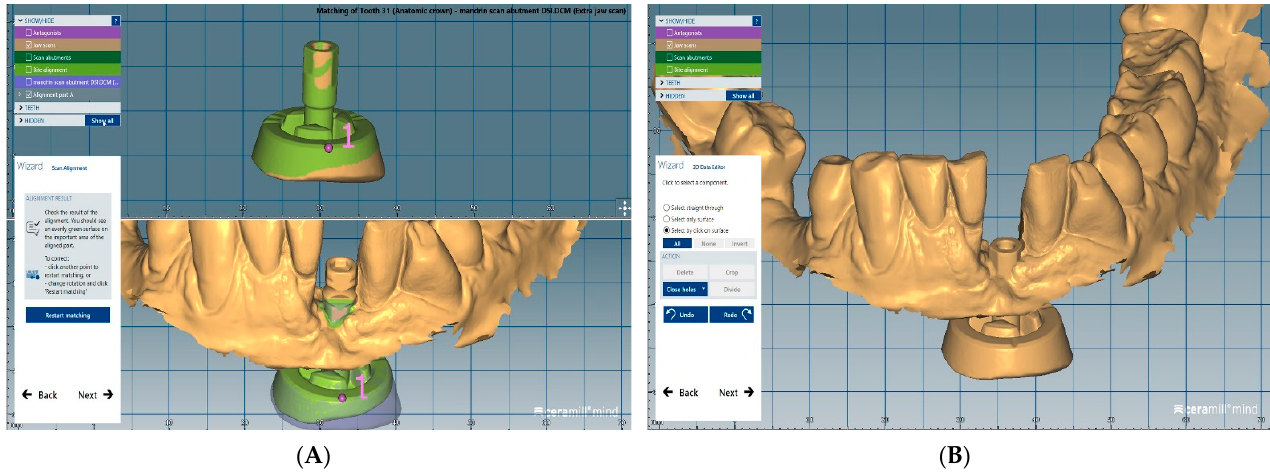
Figure 6. Scan abutment transfer indexing: ( A ) index point; ( B ) superimposed STL files.